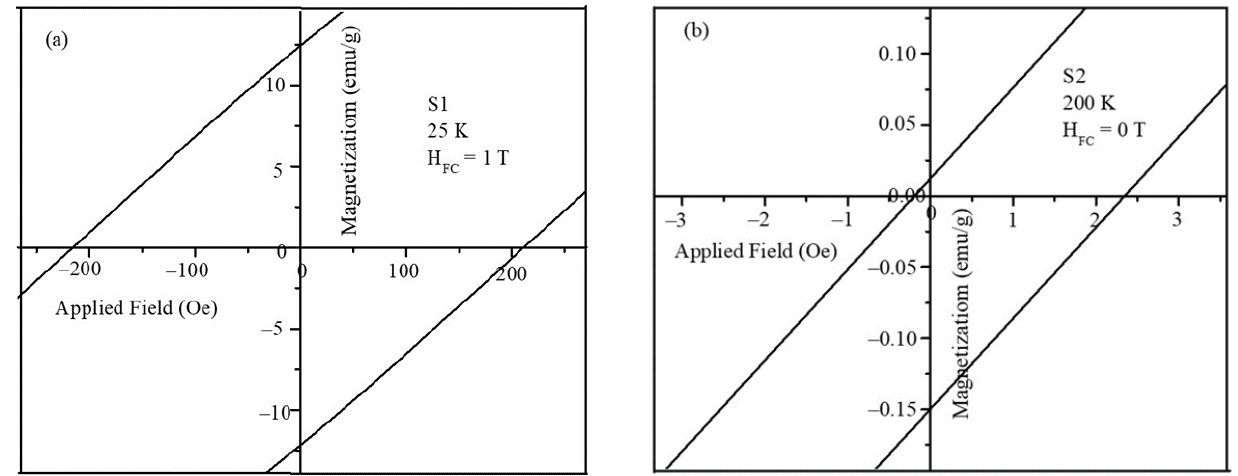
Figure 8. Zoomed portion of the MH plots used for the exchange bias calculations ( a ) S1 at 25 K under 1 T and ( b ) S2 at 200 K under 0 T.